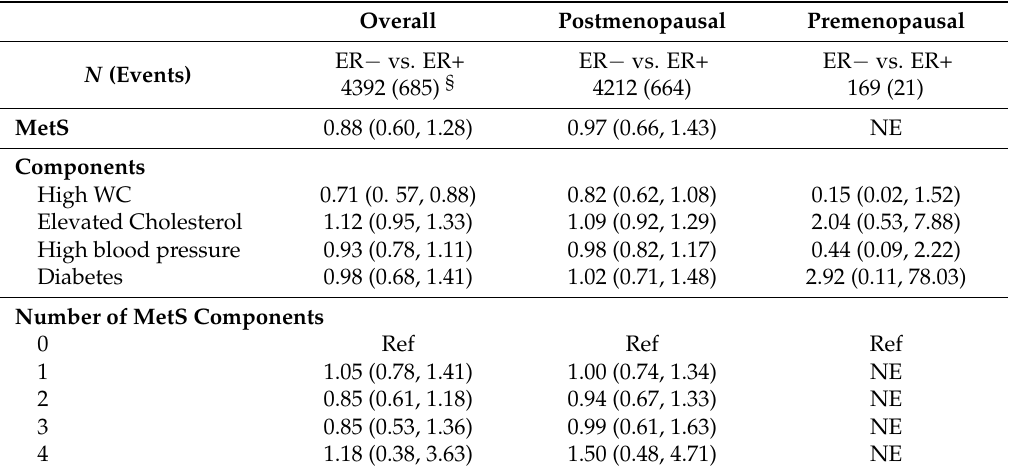
Table 3. Odds ratios (ORs) a and 95% confidence intervals for MetS and breast cancer risk by hormone receptor subtype δ and menopausal status (case only).